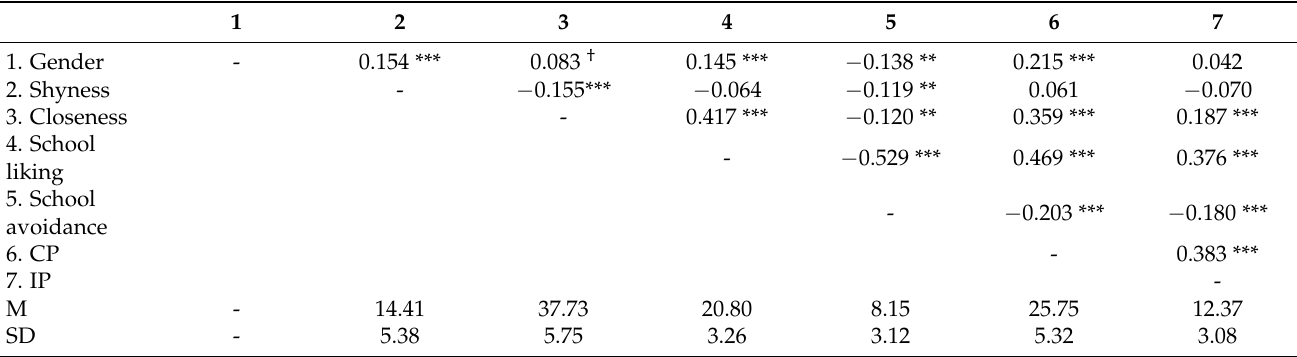
Table 3. Means, standard deviations and correlation coefficients for the study variables.